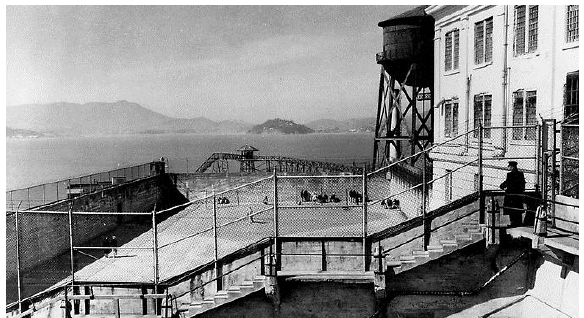
Figure 15. Recreation Yard Fencing Over the past 40 years, the condition of the catwalks has degraded significantly. The harsh climate has caused many problems with the concrete and the rebar within the concrete.